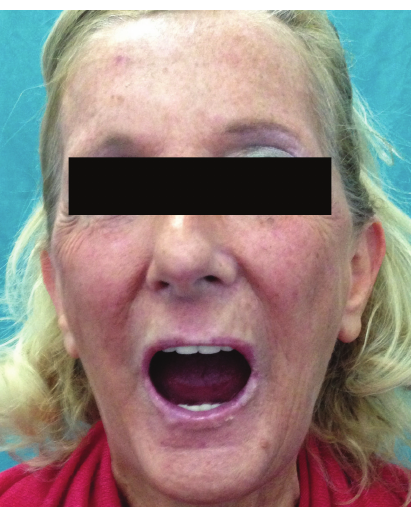
Figure 8: Aesthetic changes in the perioral region after autologous fat transplantation.